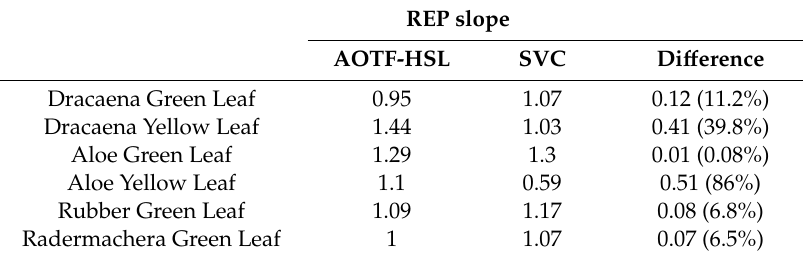
Table 3. “Red edge” slope measuring Table 4. “Red edge” area measuring results.